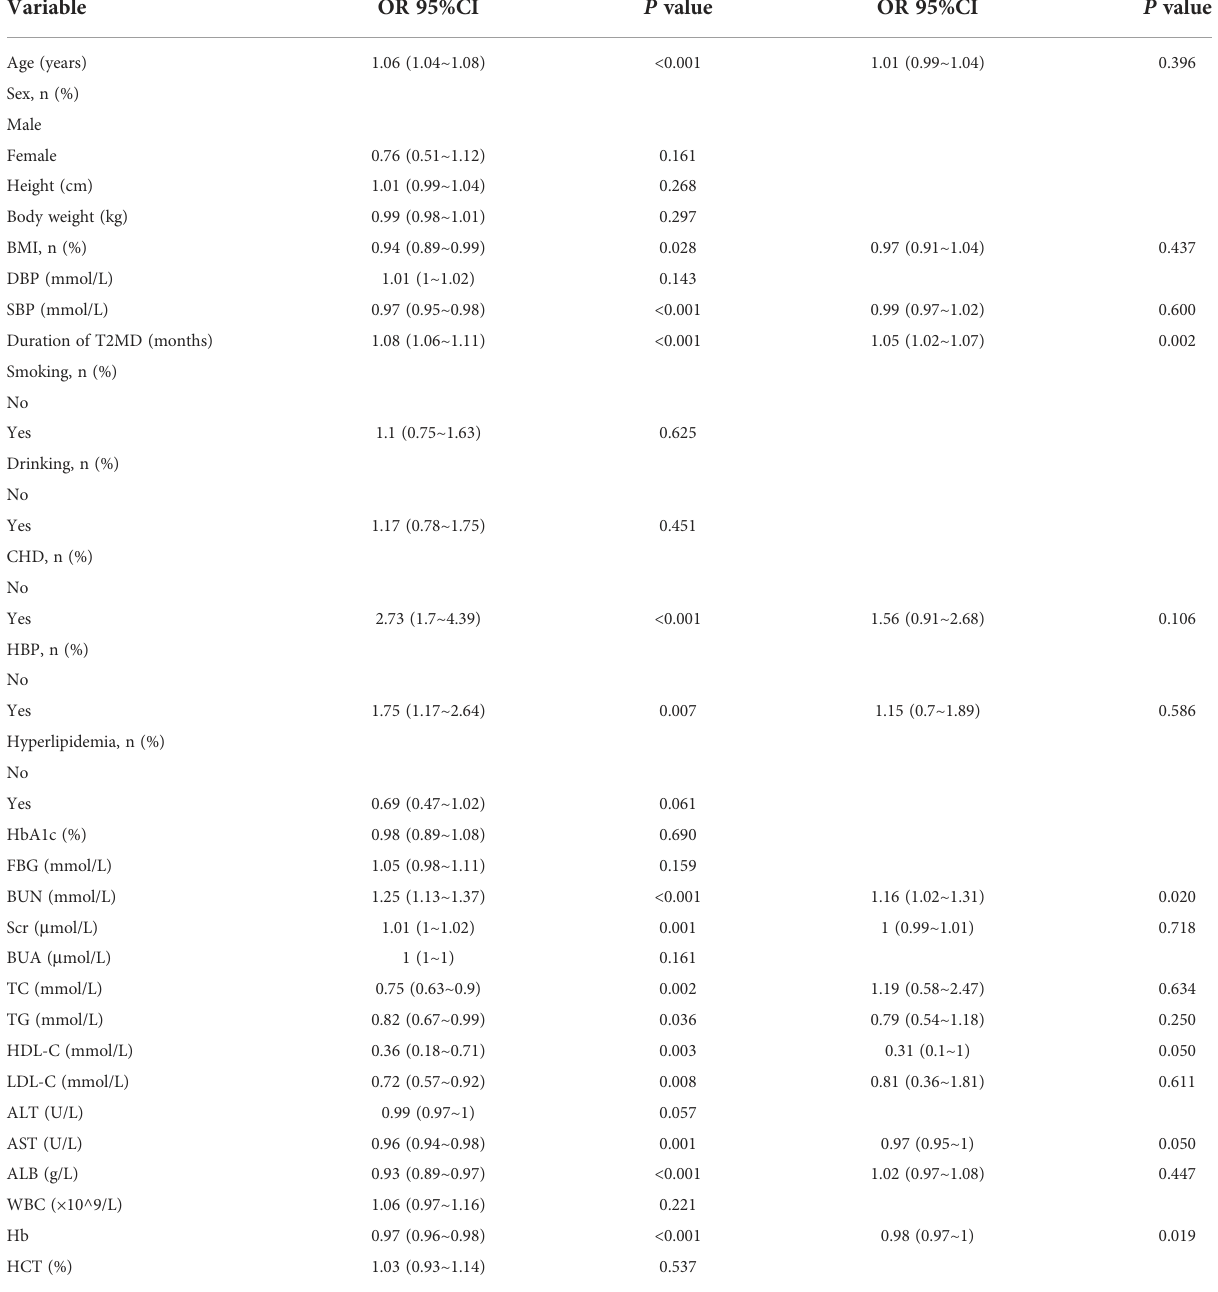
TABLE 2 Univariate and multivariate logistic regression analyses for patients with T2DM.